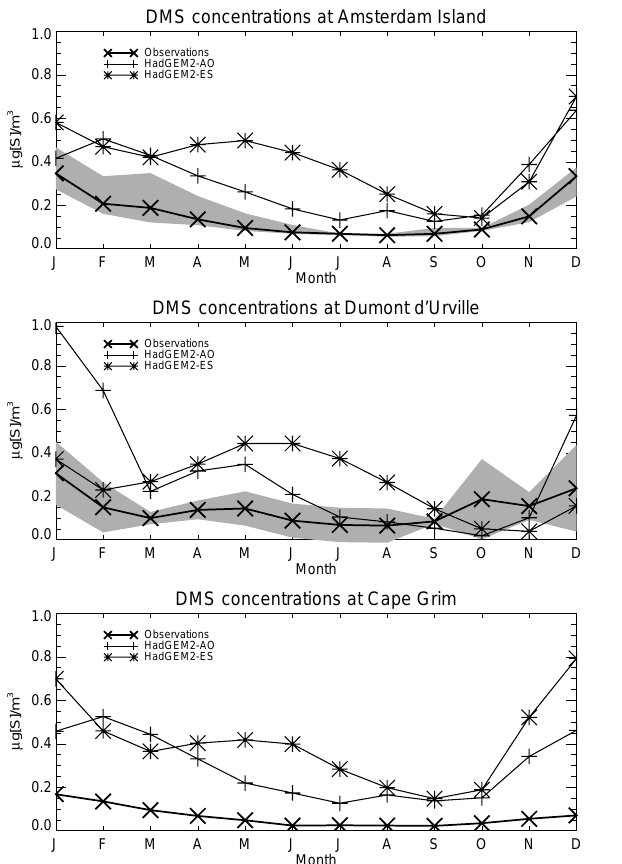
Fig. 8. Comparison of DMS concentrations in the southern mid and high latitudes with the HadGEM2 simulations; with (HadGEM2- ES) and without (HadGEM2-AO) interactive ocean biology. Ob- servations are from Ayers et al. (1991), Jordain et al. (2001) and Nguyen et al. (1992). For Amsterdam Island the shaded area spans the 5–95% range of the observations, for Dumont d’Urville it spans the ± 2 standard deviation range. For Cape Grim only the mean concentrations are available.